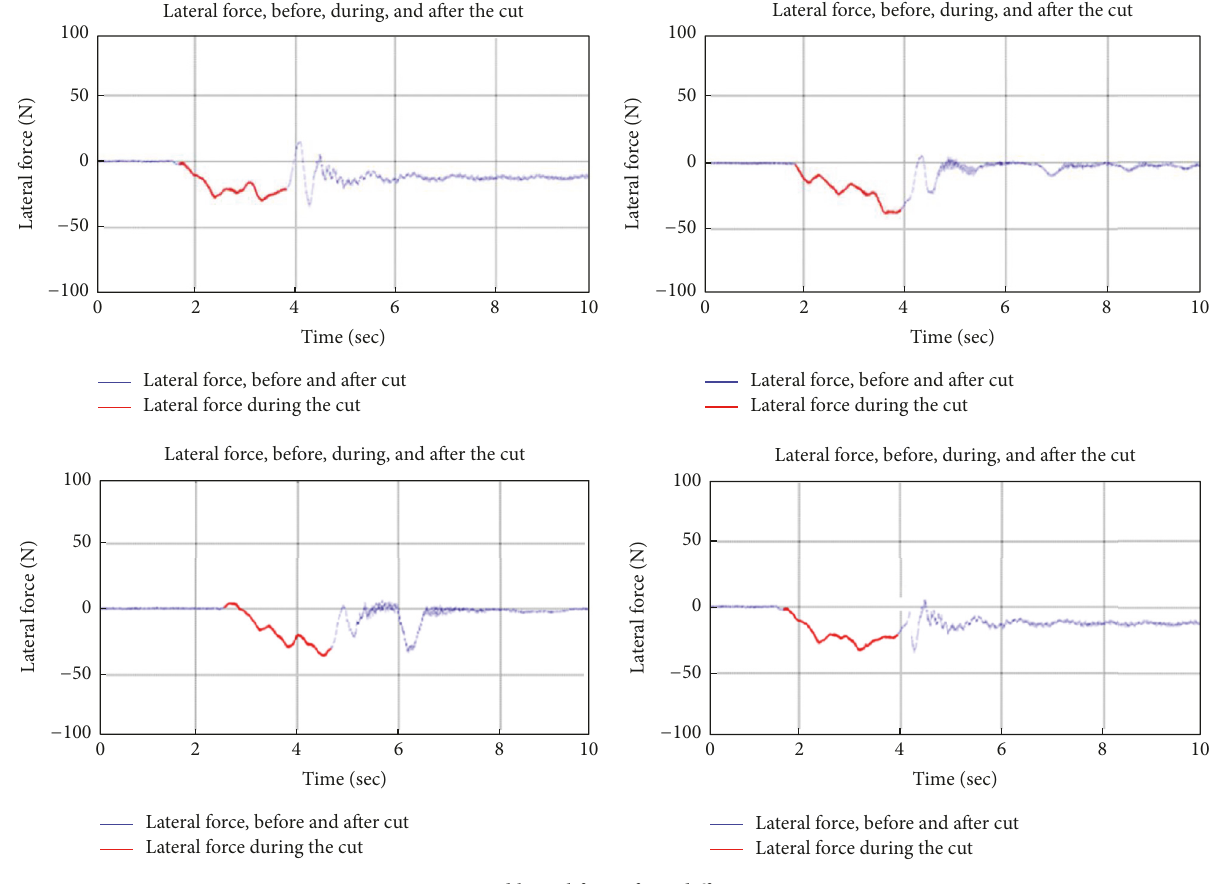
Figure 9: Measured lateral force, for 4 different cuts, 2800 rpm.